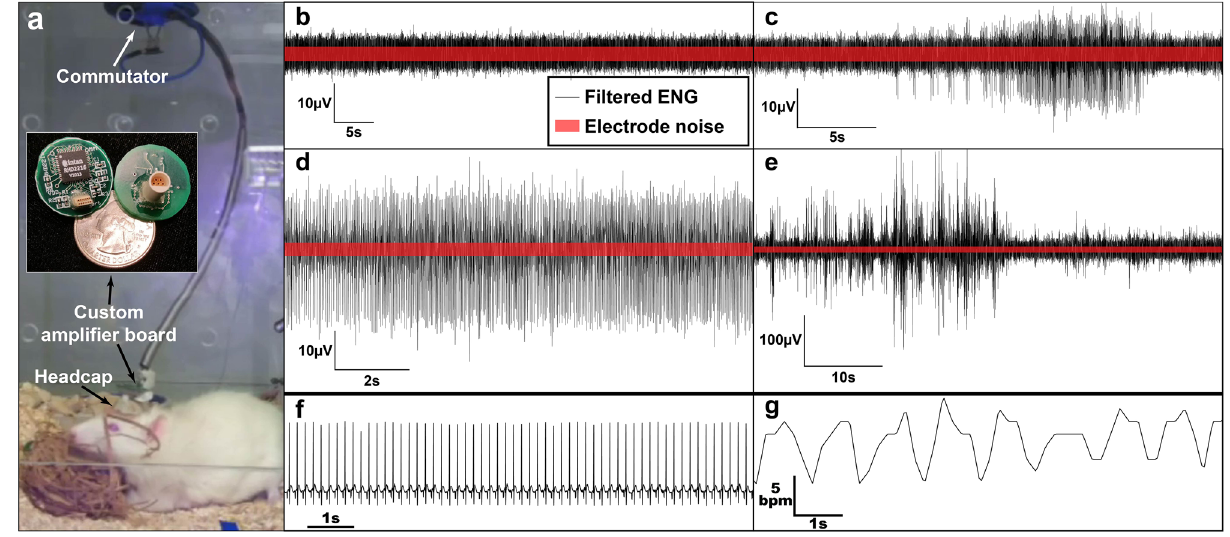
Figure 2. Awake recording setup and sample data. Red bars show electrode noise levels (calculated from electrode impedance and input amplifier noise). ( a ) Chronic non-anesthetized recording setup. The rat has a connector mounted to the skull headcap, where a custom amplifier board (inset image) is connected. The cable is routed to a commutator which allows the rat to move around without the cable becoming tangled or twisted. A metal spring is used to protect the cable from being chewed on. This setup can be used for 24/7 continuous recording (purple glow is glare from an infrared-equipped camera). ( b ) Quiet baseline, where there are few/ no spikes significantly above the baseline. This is the most common type of activity observed, especially under anesthesia. ( c ) Intermittent spiking, where spikes are observed but appear and disappear quickly. ( d ) Spike most common without anesthesia but occurs with anesthesia as well. ( f ) Simultaneously recorded ECG . ( g ). Heart rate calculated from